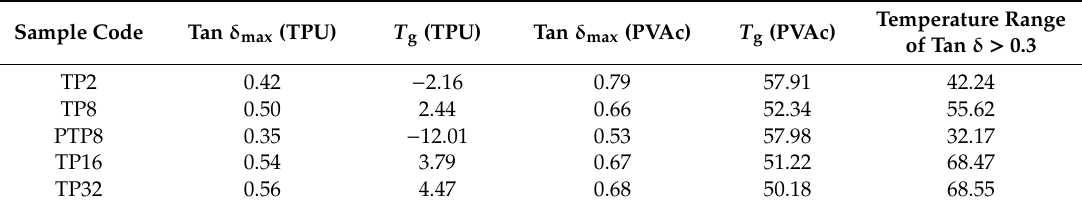
Figure S1: Dynamic equilibrated energy variation vs. simulation time: (1) TPU chain; (2) PVAc chain and (3) AO-70 chain. Figure S2: Dynamic equilibrated energy variation vs. simulation time: (1) TA-32 amorphous cell and (2) PVAc-32 confined layer. Figure S3: Dynamic equilibrated energy variation vs. simulation time of TP32: (1) the first 2 ns and (2) the last 4 ns. Figure S4: SEM image of